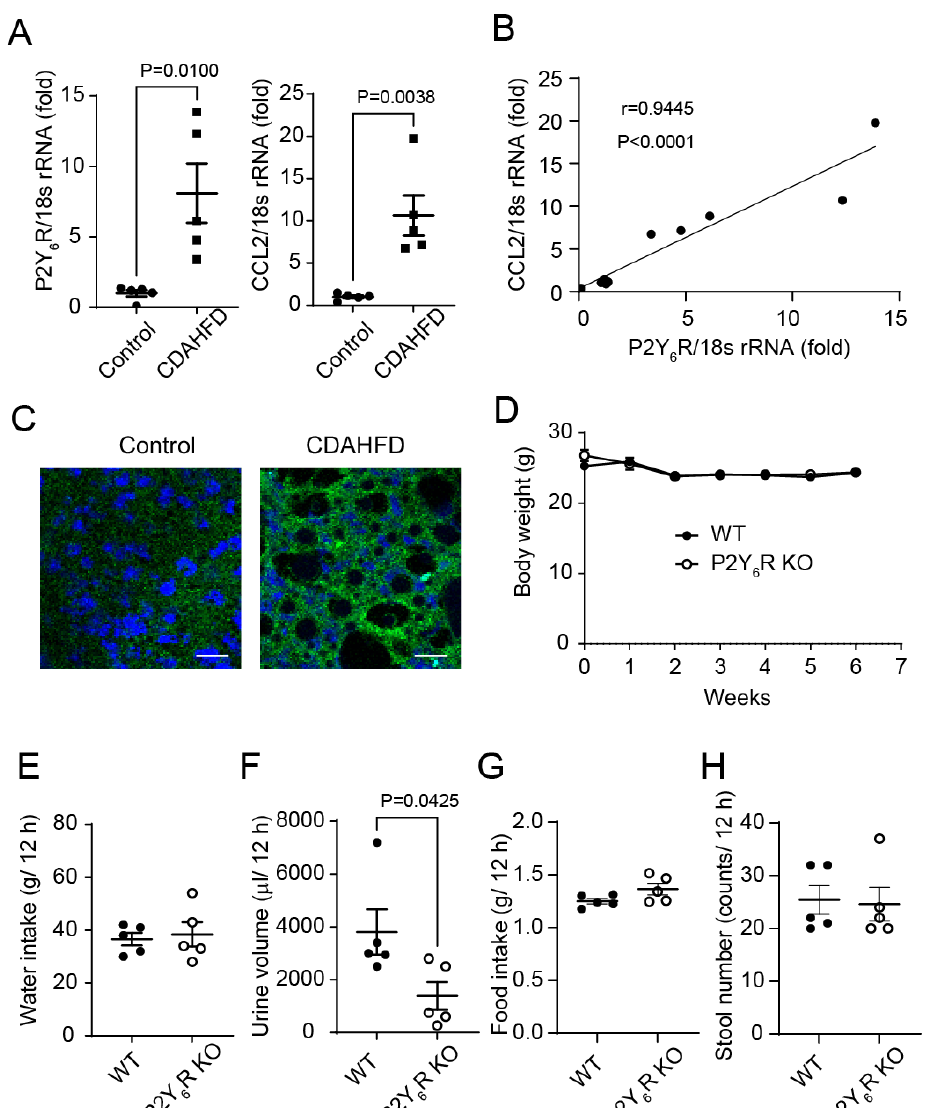
Figure 2. Effects of P2Y 6 R knockout on body status changes induced by CDAHFD. ( A ) The mRNA expression of P2Y 6 R and CCL2 in the livers of C57BL/6J mice fed with standard diet (control) or CDAHFD for 6 weeks ( n = 5 in each group). ( B ) Correlation diagram between the expression levels of P2Y 6 R and the expression levels of CCL2 in mouse liver. ( C ) Immunohistological staining of P2Y 6 R in the liver of mice fed with standard diet or CDAHFD for 6 weeks. Scale bar: 40 μ m. CDAHFD were fed to WT and P2Y 6 R KO mice for 6 weeks. ( D ) Body weight. ( E ) Water intake. ( F ) Urine volume. ( G ) Food intake. ( H ) Stool number. Data are shown as the mean ± SEM ( n = 5 in each group). Student’s t test ( A , F ). Pearson ’ s product moment correlation coefficient ( B ).